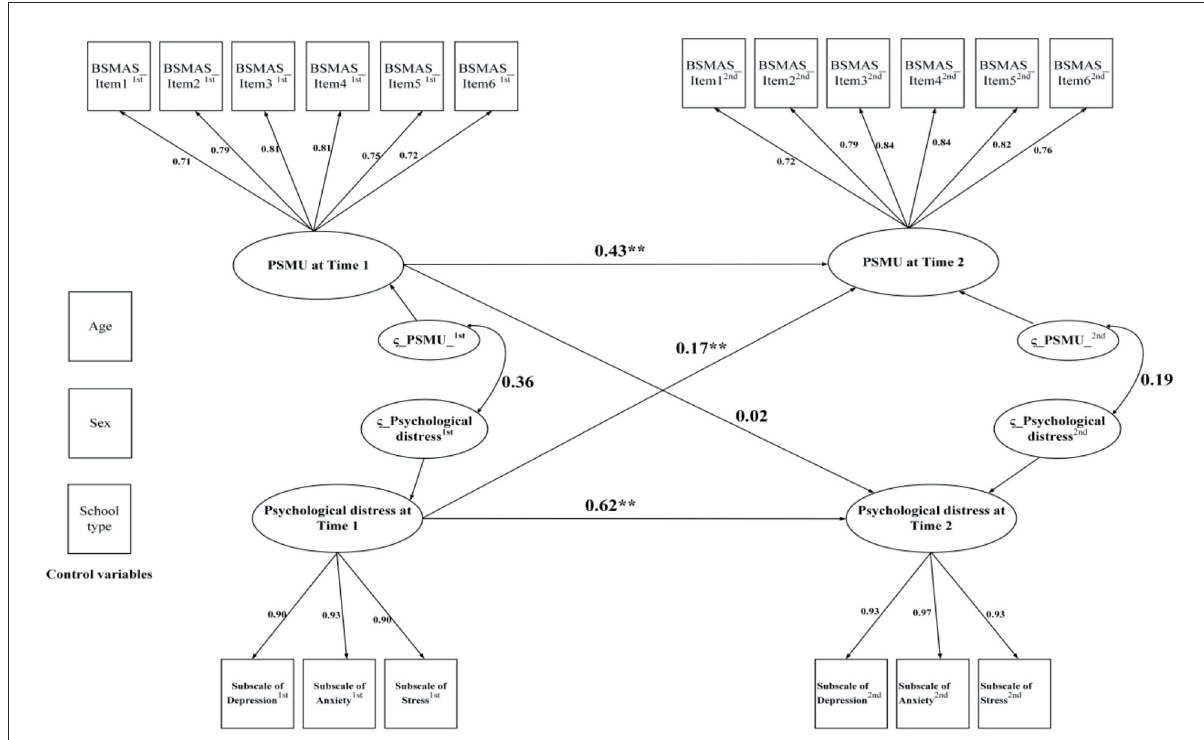
FIGURE3 Cross-lagged panel model of problematic social media use and psychological distress; PSMU, Problematic social media use; BSMAS, Bergen Social Media Addiction Scale. ** p < 0.01.